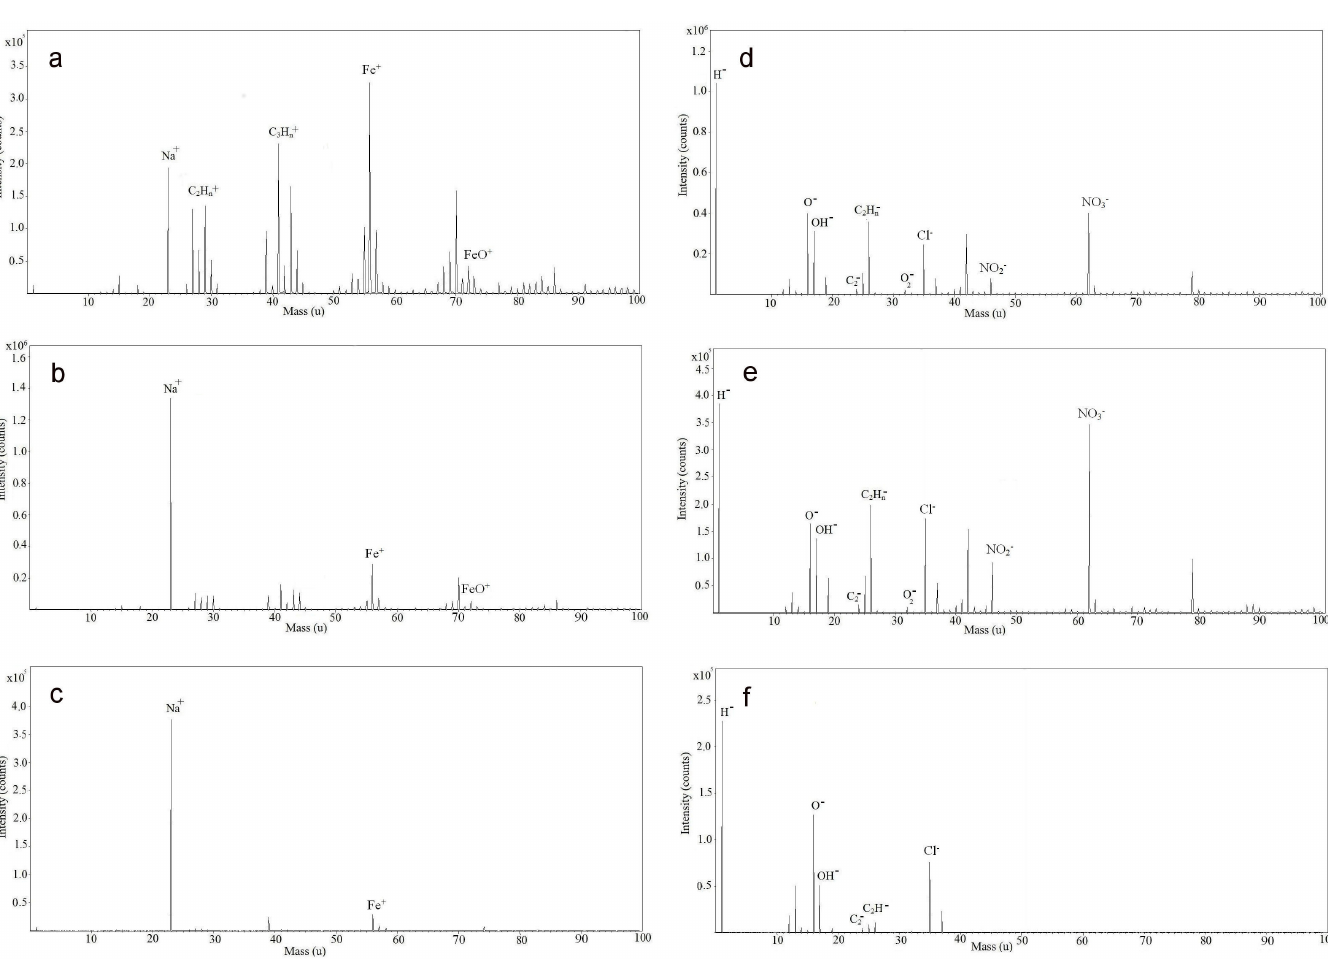
Fig 6. Positive TOF-SIMS spectra of (a) bare, (b) positively charged and (c) negatively charged SPIONs; negative TOF-SIMS spectra of (d) bare, (e) positively charged and (f) negatively charged SPIONs after incubation with the biofilm. The intensity of each peak was different for each sample. The intensity peak ratios changed from one sample to the